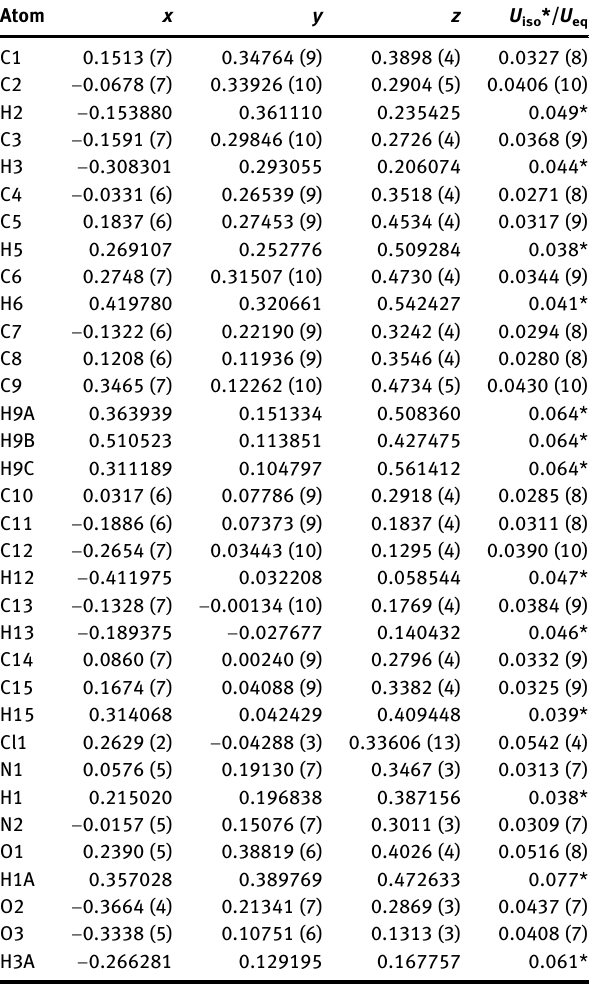
Table  : Fractional atomic coordinates and isotropic or equivalent isotropic displacement parameters (Å 